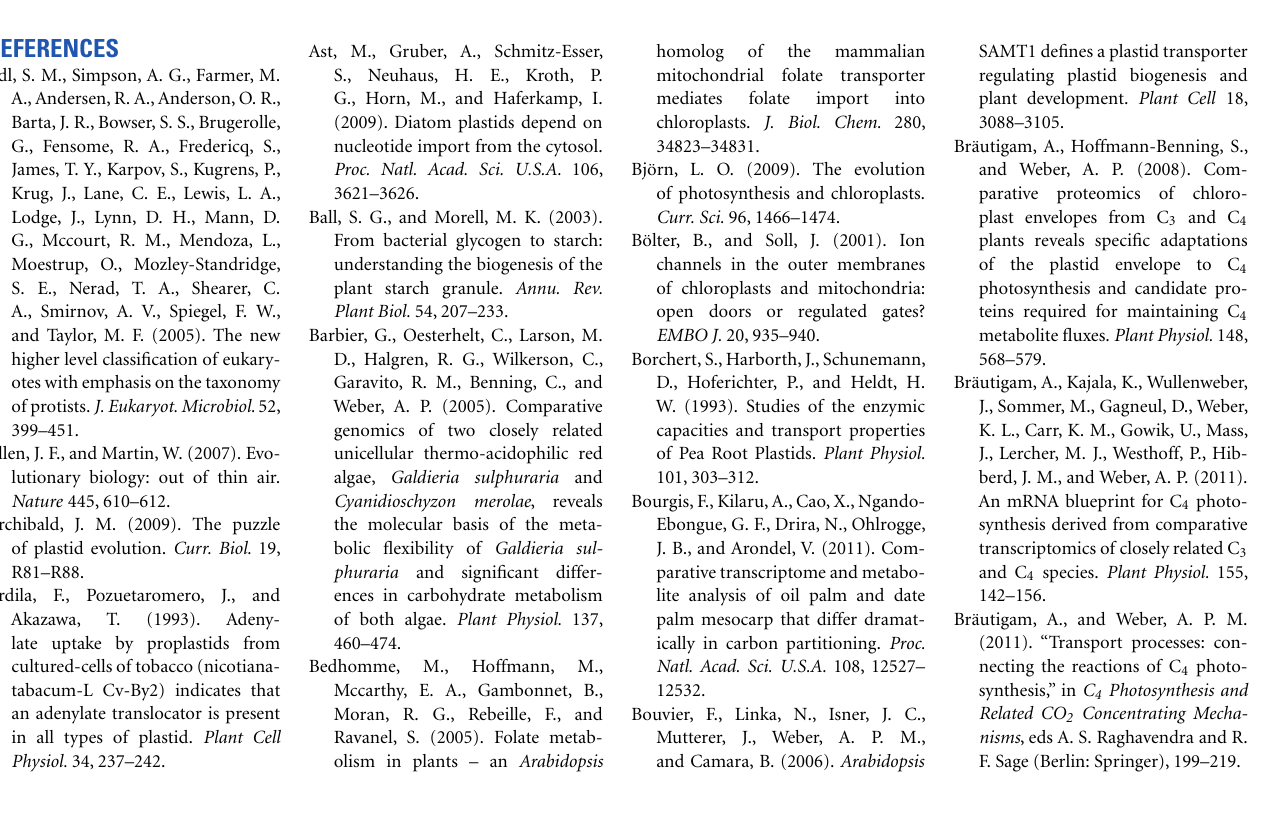
FIGURE 7 | Model for the pyruvate uptake into the plastid. The two-translocator system responsible for pyruvate uptake into the plastid of certain C 4 species is based on a sodium:pyruvate cotransporter (BASS2) and a sodium:proton antiporter (NHD1). NHD1 is able to establish a sodium gradient across the envelope membrane, which in turn drives pyruvate import by the cotransporter BASS2. Abbreviations: BASS2, BILE ACID:SODIUM SYMPORTER FAMILY PROTEIN 2; NHD1, sodium:proton antiporter; OAA, oxaloacetate; PEP, phospho enol pyruvate; PPT, PEP/phosphate